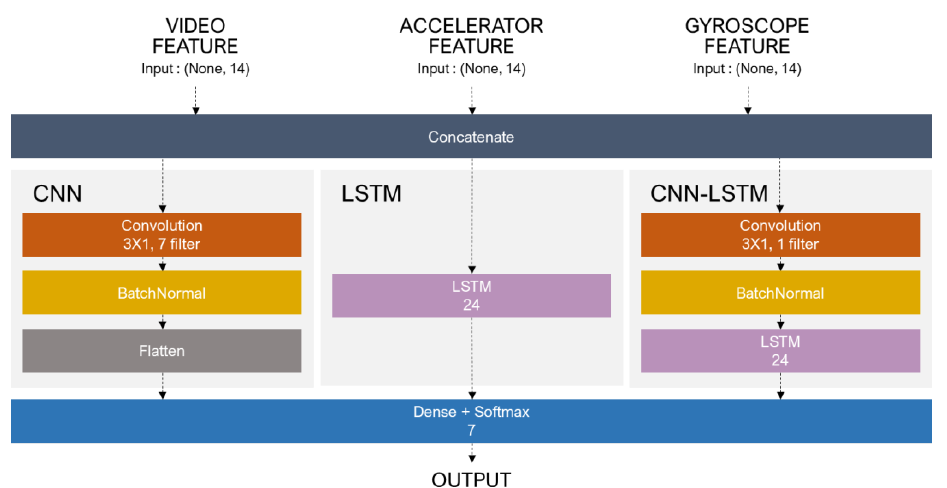
Figure 3. Model structures of CNN, LSTM, and CNN-LSTM for feature fusion.